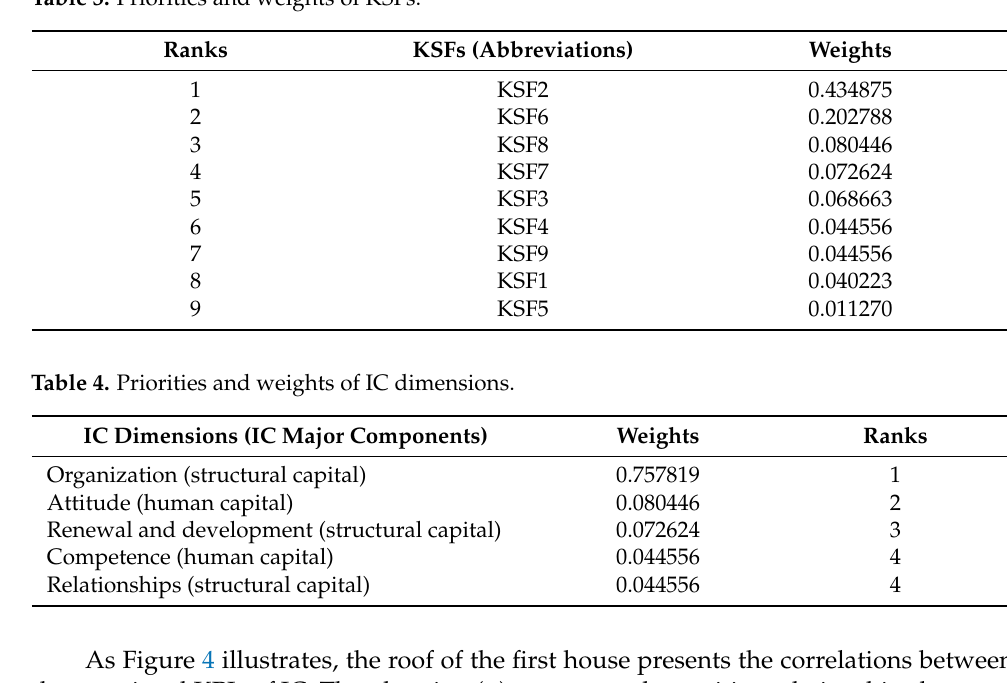
Table 3. Priorities and weights of KSFs.